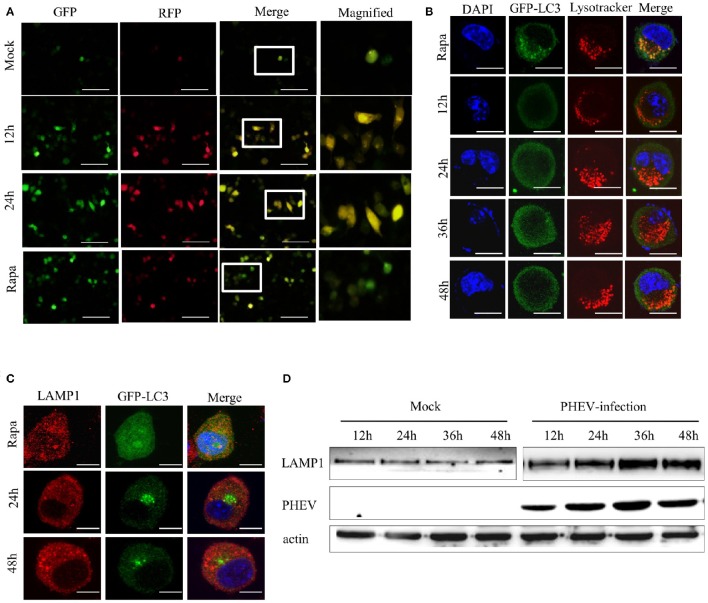
PHEV activates autophagosome formation but prevents its fusion with lysosomes. (A) Neuro-2a cells were transfected with mRFP-GFP-LC3. As the positive control for induction of autophagy, Neuro-2a cells were transfected with mRFP-GFP-LC3 and then treated with complete medium supplemented with 200 μM rapamycin for 3 h. At 0, 12, and 24 h post-transfection, the cells were fixed and assessed with GFP and mRFP fluorescence. Scale bars: 50 μm. (B) Neuro-2a cells were used to analyze the colocalization of LysoTracker-stained acidified vesicles and GFP-LC3-positive autophagosomes in the mock-infected and PHEV-infected cells at 12, 24, 36, and 48 h. Representative images are shown in Figure 5B. (C) Furthermore, the fusion of autophagosomes with lysosomes was analyzed as colocalization of the autophagosome marker GFP-LC3 with the lysosome marker LAMP1. Nuclear DNA was stained with DAPI. One of the three experiments conducted is shown. (D) Western blotting analysis of LAMP1 changes in PHEV-infected cells for 12, 24, 36, and 48 h were shown in Figure 5D, compared with the relevant times in mock cells. Scale bars: 10 μm.